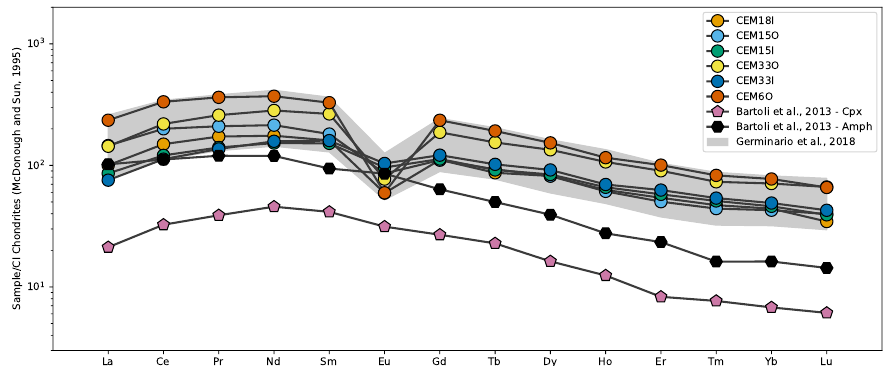
Figure 6. Spider diagrams of Euganean Hills pyroxenes. Normalised to chondritic composition [39]. Gray shadow: variation range of clinopyroxene by [36]; Clinopyroxene and amphibole from